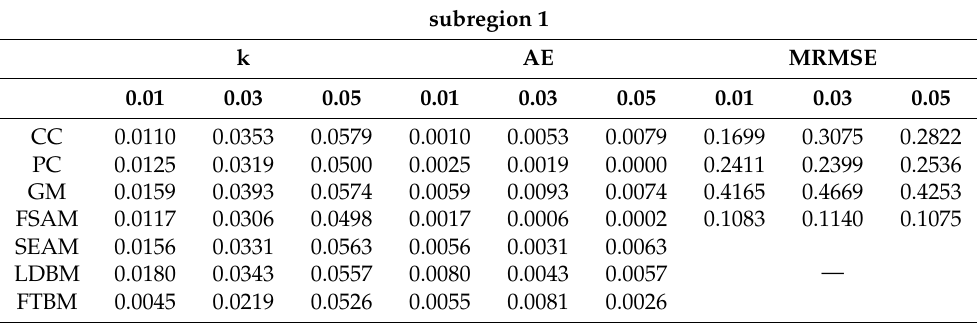
Table 5. The results of all test methods on subregion 1, subregion 2, and subregion 3 with spectral resolution of 9.6